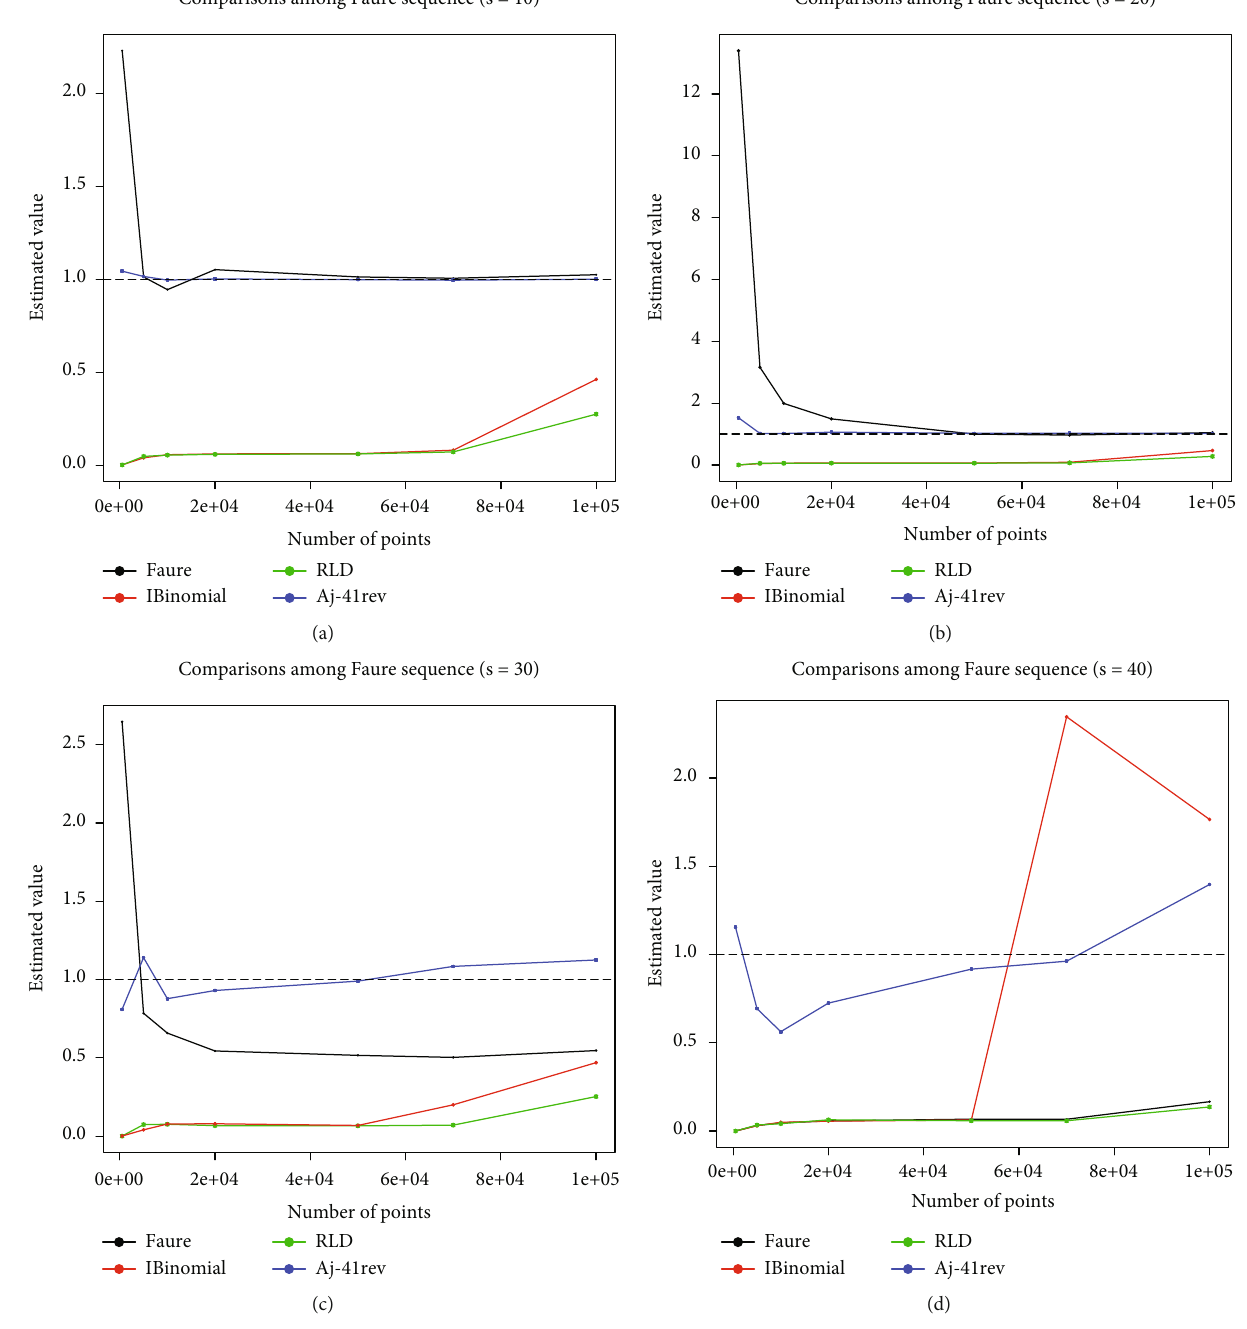
Figure 5: Estimates of the integral I